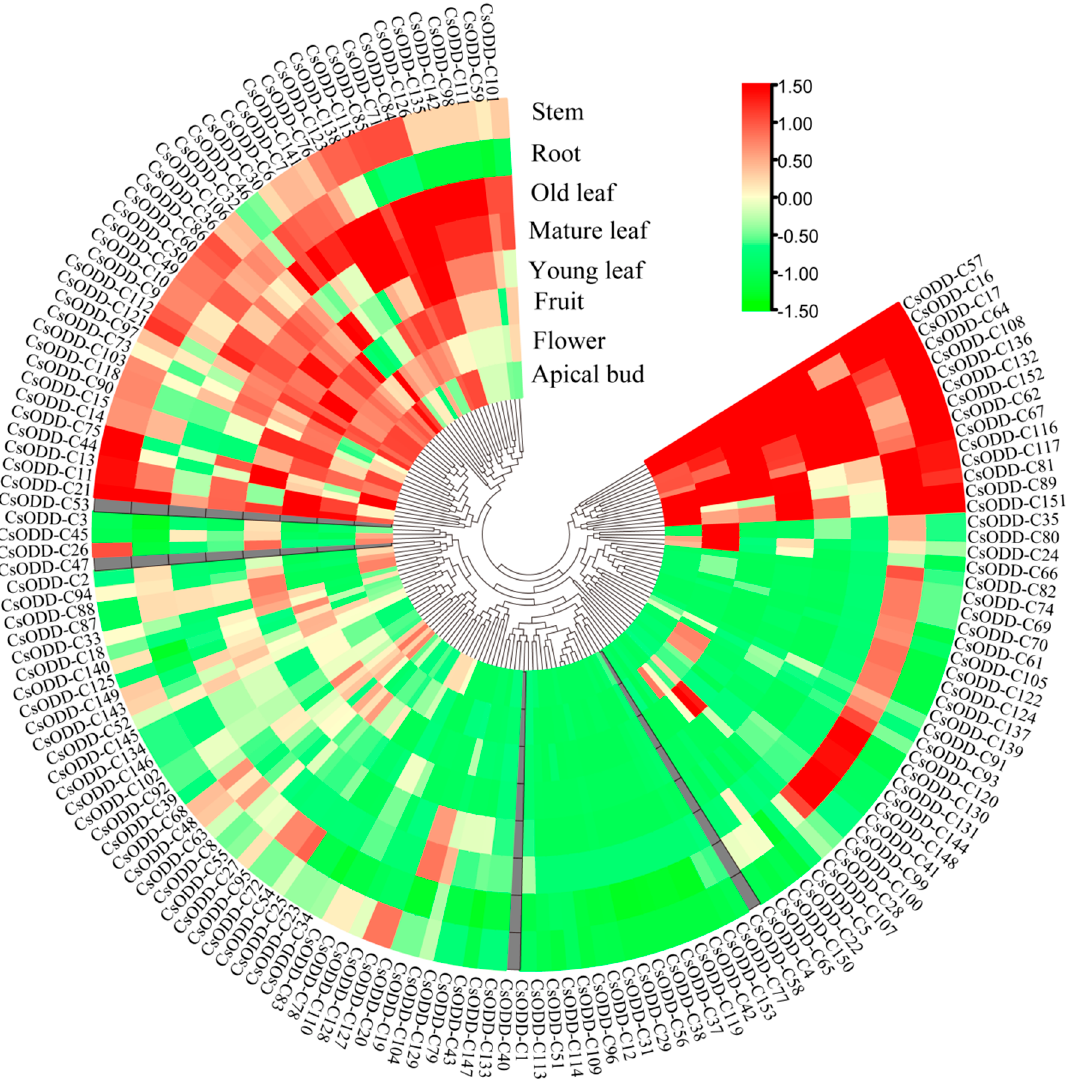
Figure 5. Gene − expression patterns of Cs2ODD − C genes in different organs of C. sinensis by RNA − seq. The scale bars represent the log2 transformations of the RPKM values. Green and red columns represent the down- and upregulated Cs2ODD − C genes, respectively.